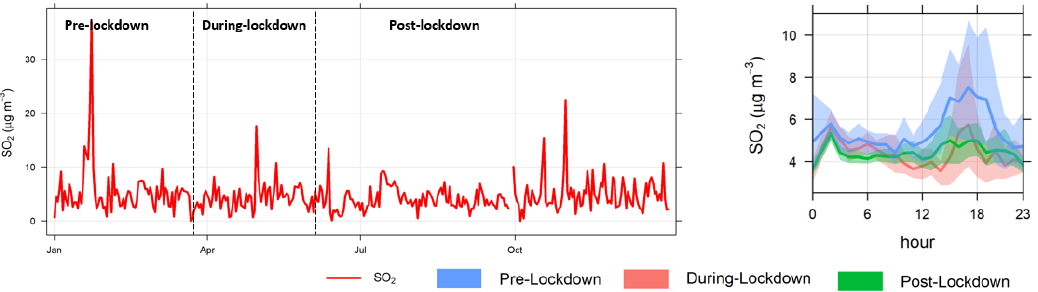
Figure 9. The variation in 24 h concentrations and hourly diurnal profile of SO 2 at Rocklea monitoring station for different periods.